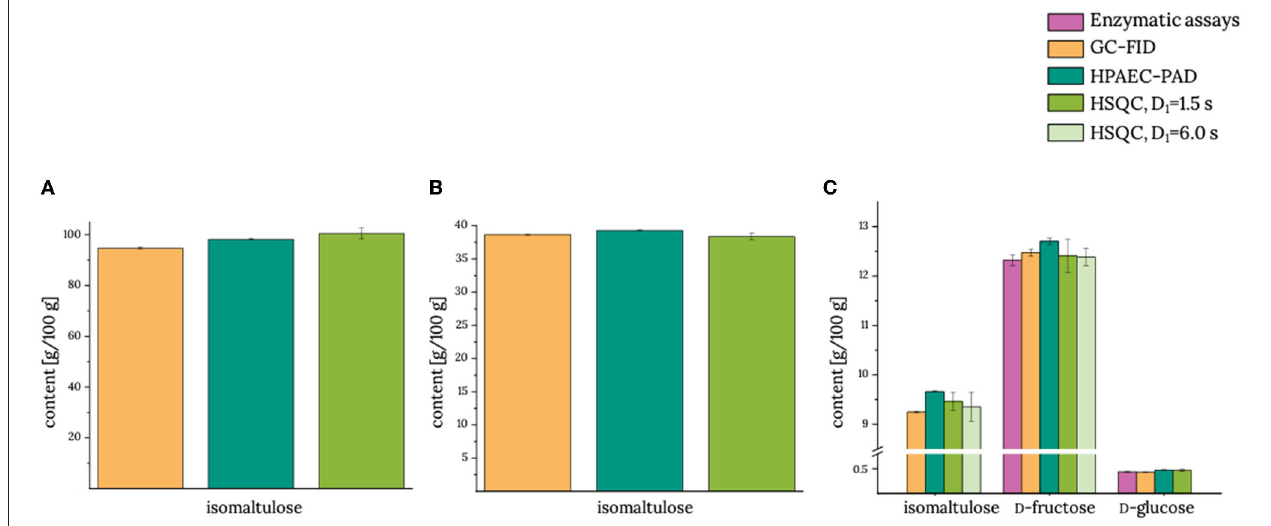
FIGURE 2 | Contents of isomaltulose and other sugars (if applicable) in (A) product 1 , (B) product 2 , and (C) product 3 . GC-FID, gas chromatography with flame ionization detector; HPAEC-PAD, high-performance anion-exchange chromatography with pulsed amperometric detection; HSQC, heteronuclear single quantum coherence; D 1 , interscan delay. Analyses by using the reference methods were performed in duplicate using the half range to demonstrate the spread of the data. HSQC measurements were performed in triplicate determination, and the standard deviation is given. Actual data are given in Supplementary Table S2